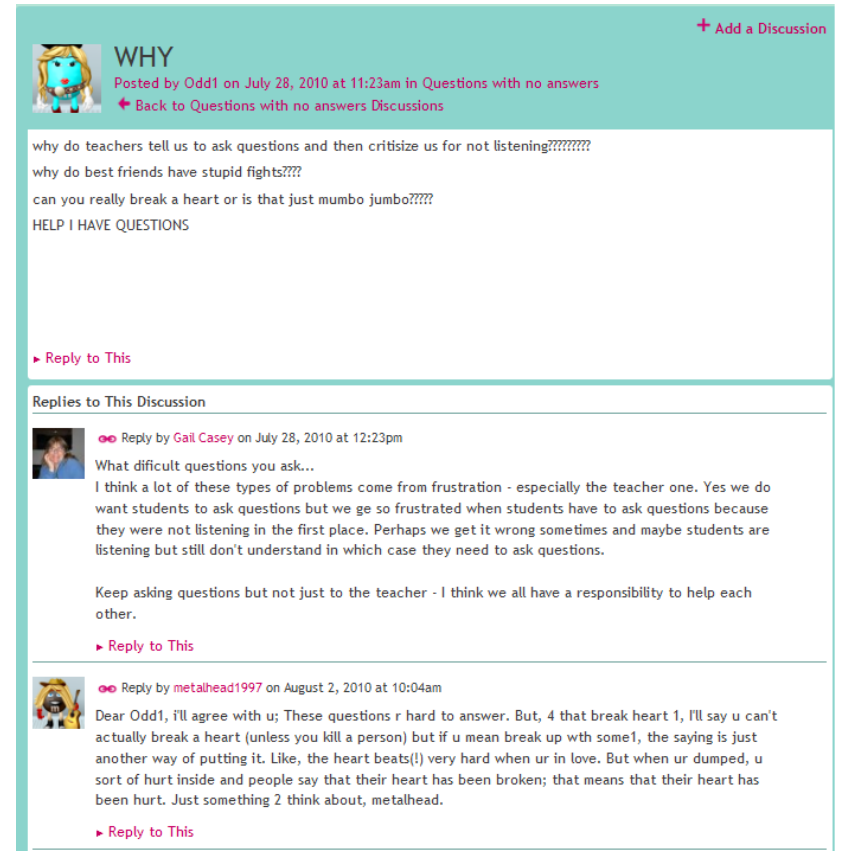
Figure 9. Student-directed group formed in frustration in the classroom. When signed into the Ning, students often worked in different ways than they did when in the traditional classroom. One example of this was when students worked on projects that involved a number of different classes. The researcher established these projects to pro- mote cross-curriculum work, and students usually found them interesting. These project work online groups gave no reference to specific classes, so most students did not know which group was related to a particular class. It was interesting to watch Year 7 students confidently connect with those in Year 10 as equals, taking on a profile of their choice. The MashUp and Data Visualisation screen clips in Figure 10 show two shared groups that were used by the researcher to encourage students to explore interesting concepts and work across